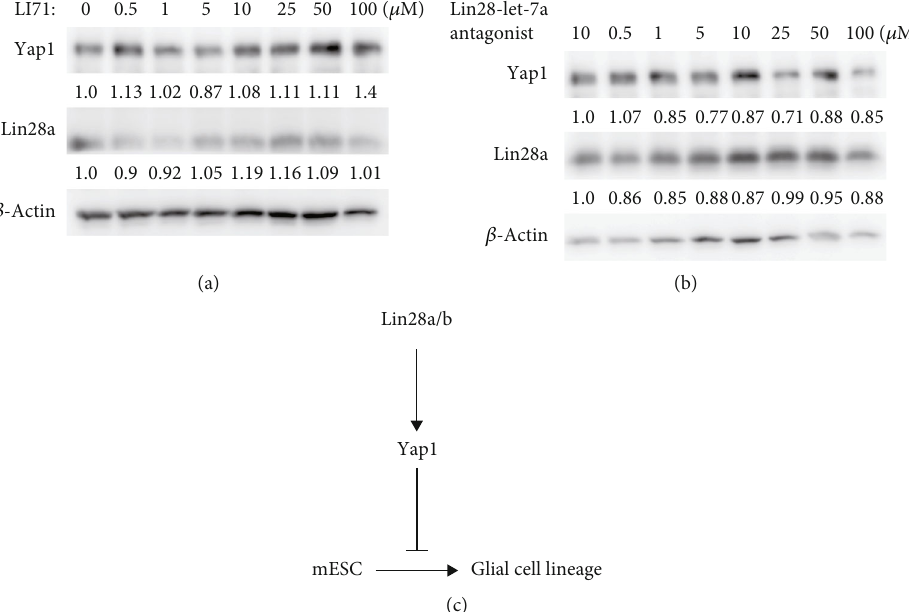
Figure 6: Induction of Yap1 by Lin28a/b in mouse ESCs was independent of Let7 pathway. (a) Western blot analyses of total proteins from Lin28a OE mouse ESCs treated with di ff erent concentrations of Lin28-let7 inhibitor (LI71) using the indicated antibodies. (b) Western blot analyses of total proteins from Lin28a OE mouse ESCs treated with di ff erent concentrations of Lin28-let7a antagonist using the indicated antibodies. (c) Schematic of the Lin28a/b-Yap1 pathway activity regulating mouse ESC di ff erentiation to glial lineage